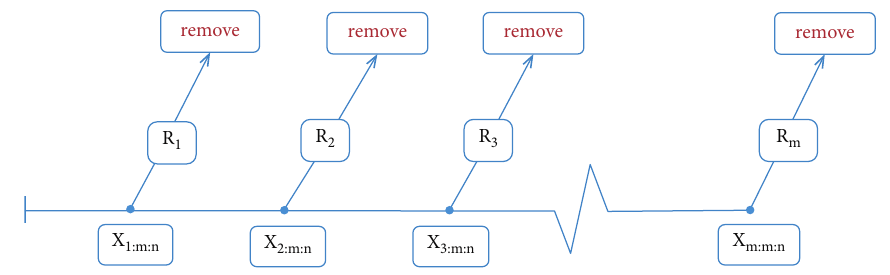
Figure 1: Type-II progressive